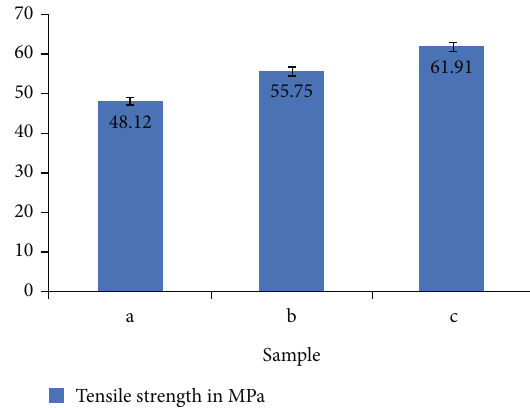
Figure 4: Tensile strength of epoxy hybrid composites.